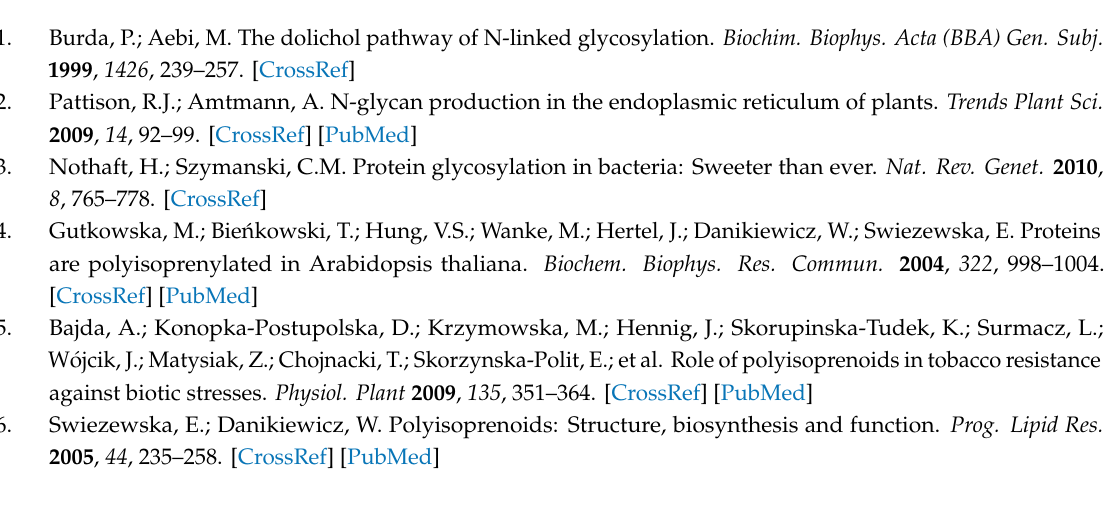
Supplementary Materials: The following are available online. Figure S1: Expression of the other Arabidopsis CPTs and content of short- and medium-chain dolichols, Figure S2: Expression of AtCPT1 in Arabidopsis leaves and chromatograms of polyisoprenoids extracted from Aradidopsis and Nicotiana leaves expressing AtCPT1, Table S1: Synthetic oligonucleotides used in this